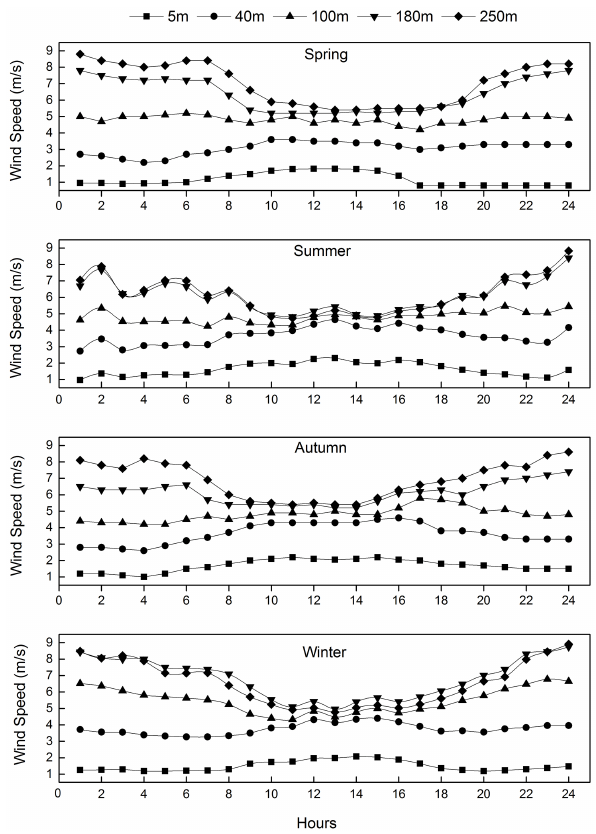
Figure 1. Diurnal variation of averaged wind speed in each season at different heights.